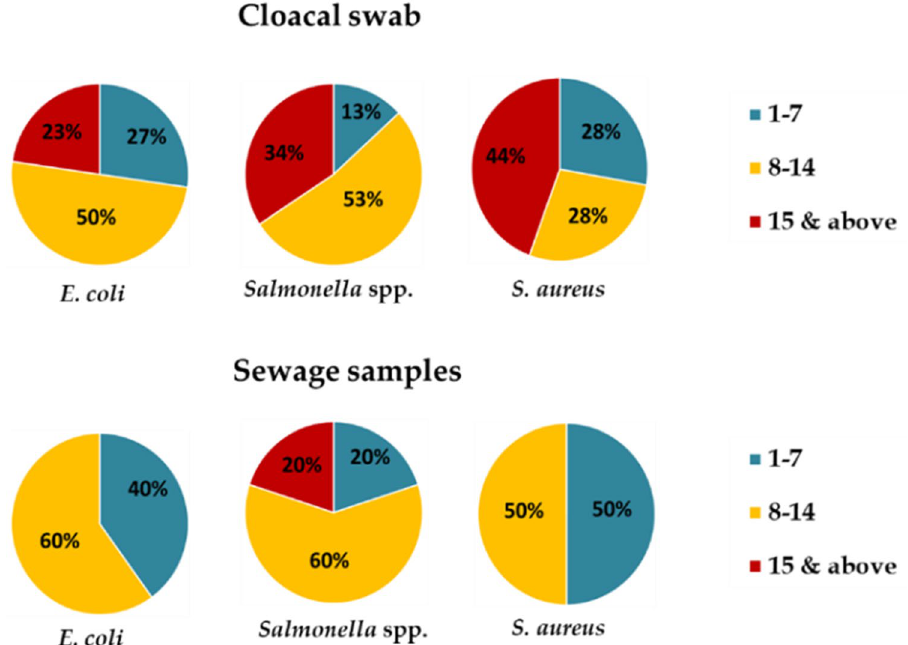
Figure 4. Resistance distribution of E. coli , Salmonella spp., and S. aureus to number of antimicrobial agents in cloacal swab and sewage